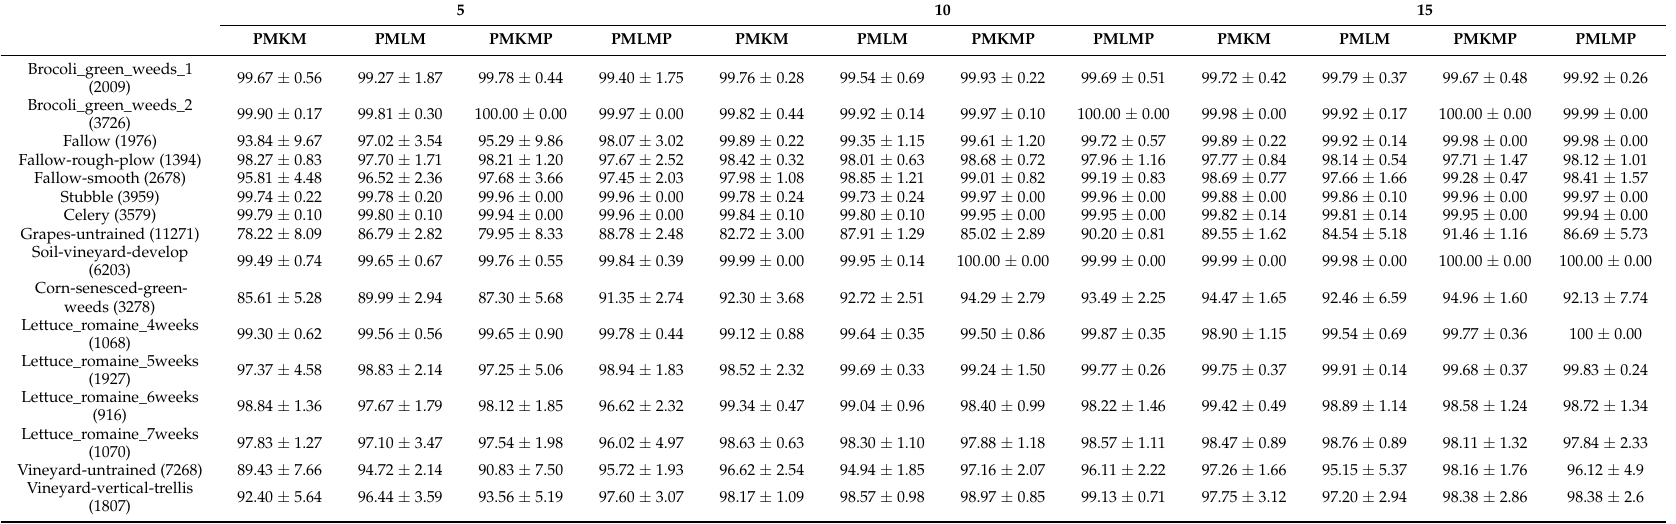
Table 3. Classification accuracy over OA (%) and its standard deviations for each class in the Salinas